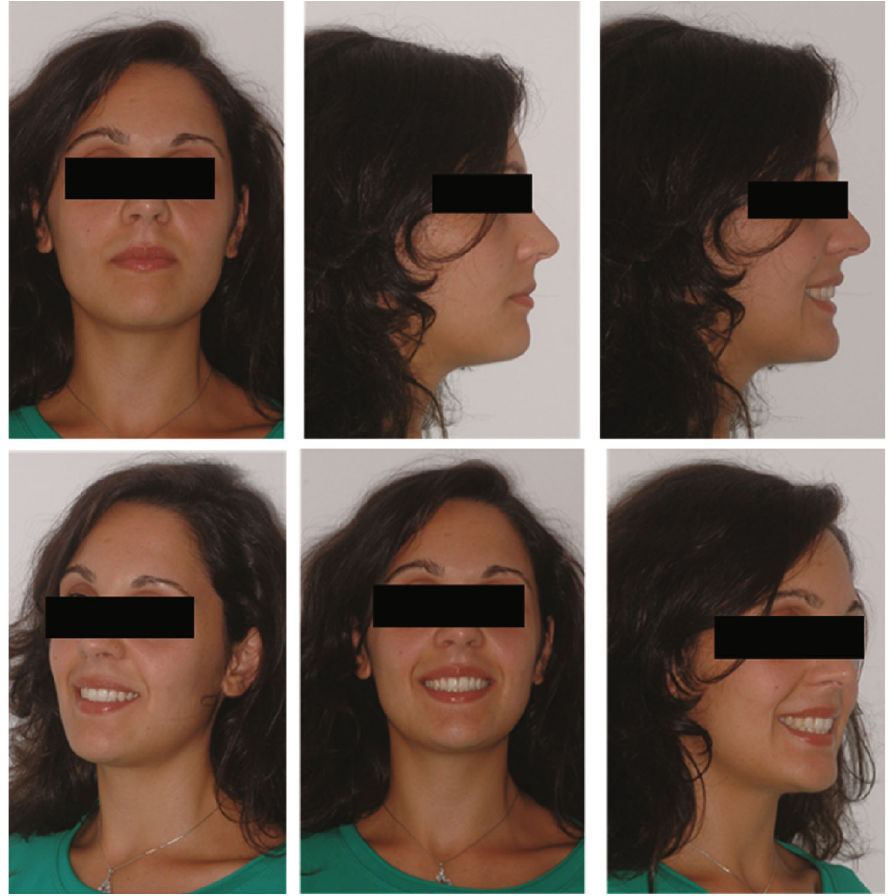
Figure 17: 10-year follow-up extraoral